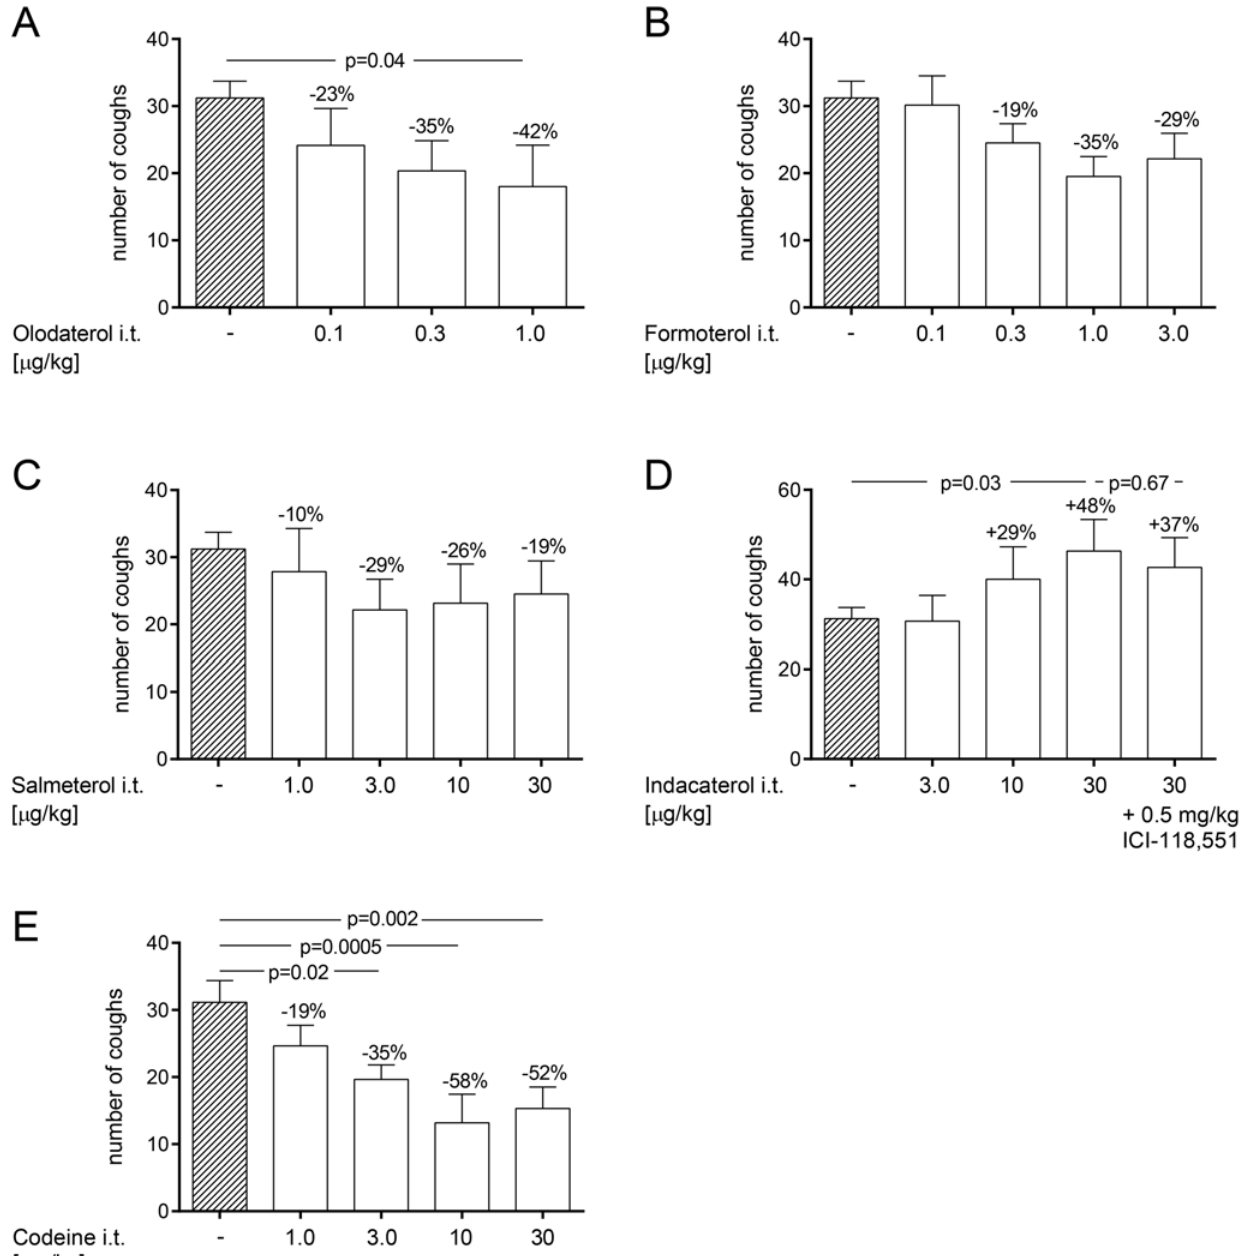
Fig 3. Effect of dry powder administration of β 2 -agonists on citric acid-induced cough in na ï ve guinea pigs.